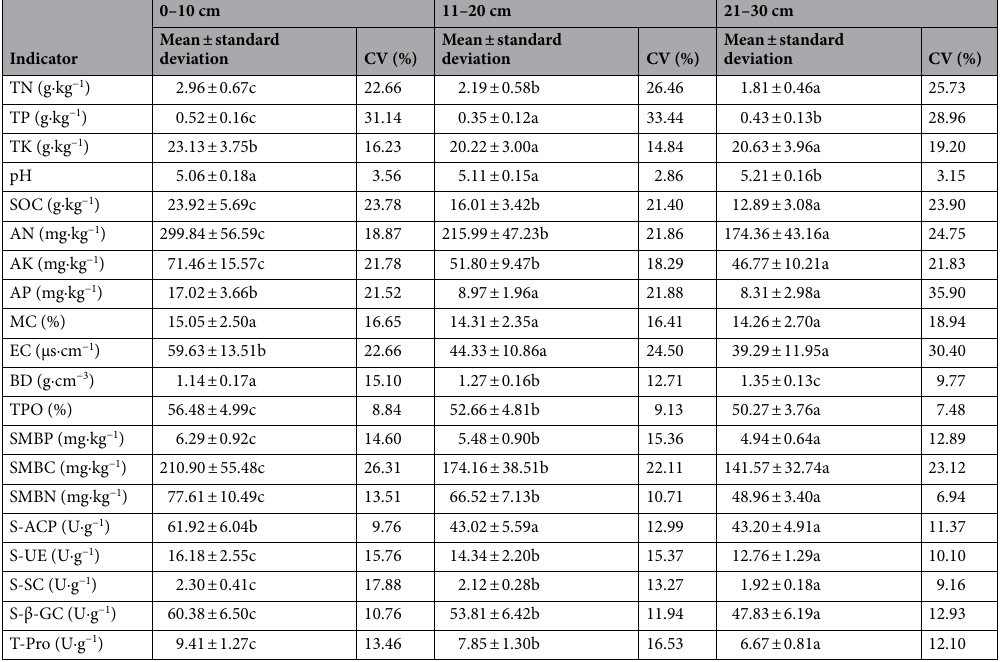
Table 2. Changes in soil chemical, physical, and biological indicators of C. dabieshanensis forests between different soil layers. There were significant differences in the one-way ANOVA of various compound patterns with different letters (LSD, p <